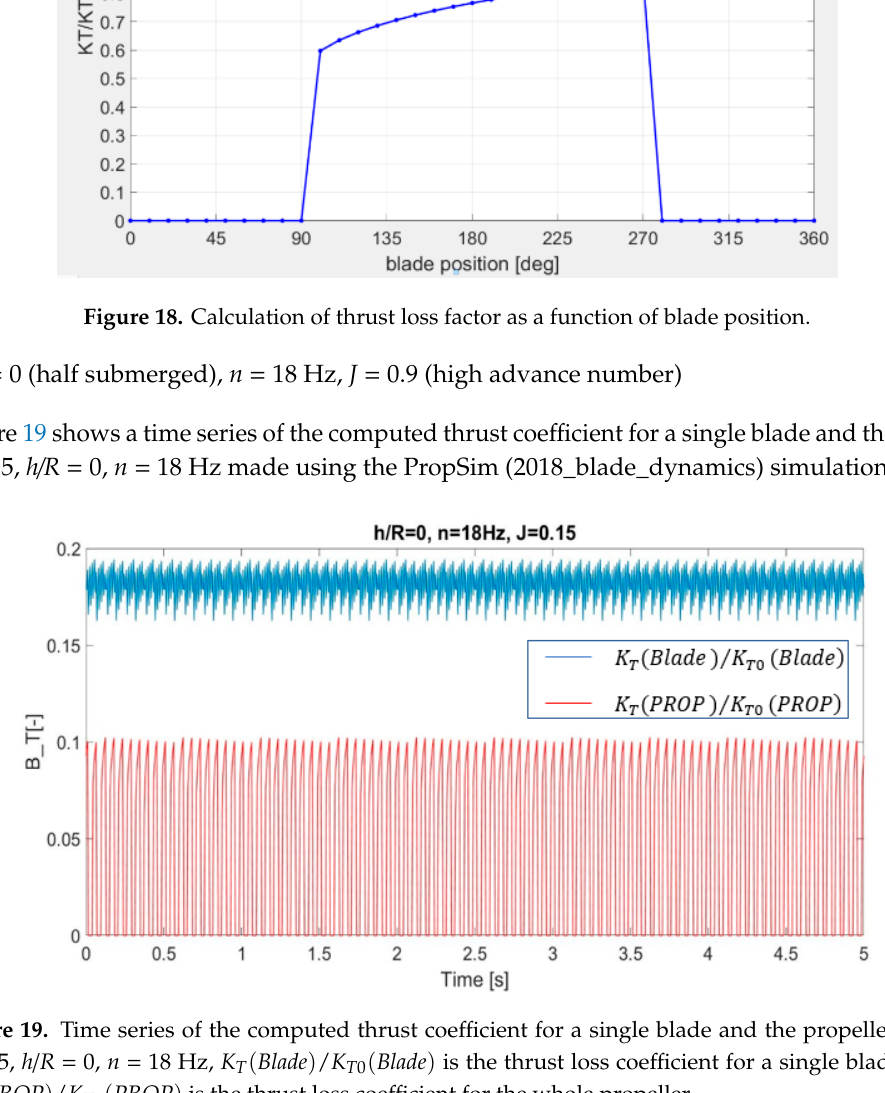
Figure 19. Time series of the computed thrust coe ffi cient for a single blade and the propeller for J = 0.15, h / R = 0, n = 18 Hz, 𝐾 (cid:3021) (𝐵𝑙𝑎𝑑𝑒)/𝐾 (cid:3021)(cid:2868) (𝐵𝑙𝑎𝑑𝑒) is the thrust loss coefficient for a single blade and K T ( PROP ) / K T 0 ( PROP ) is the thrust loss coe ffi cient for the whole propeller.